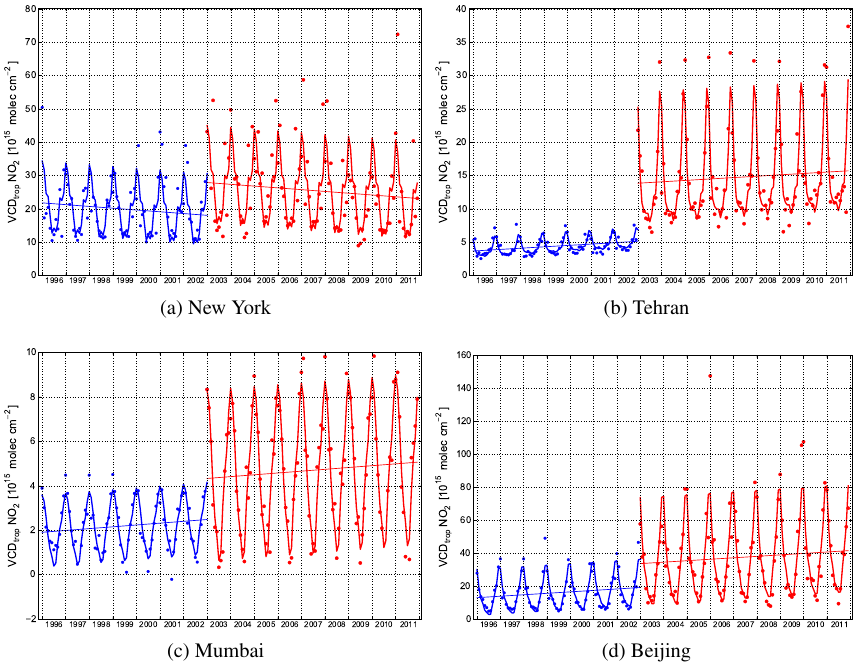
Fig. 17 : Time series of monthly VCD trop NO 2 (dots), fitted levelshift trend model (thick line), Fig. 17. Time series of monthly VCD trop NO 2 (dots), fitted level shift trend model (thick line), and linear component of the fit (straight line) and linear component of the fit (straight line) for the time periods 1996-2002 (GOME, blue) and for the time periods 1996–2002 (GOME, blue) and 2003–2011 (SCIAMACHY, 2003-2011 (SCIAMACHY, red). 53